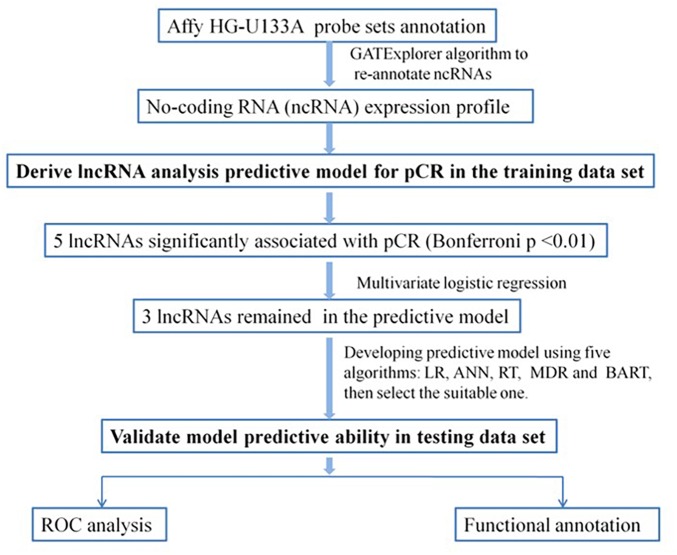
Diagram of the study. Develop predictive model for pCR and validate the efficiency of the lncRNA signature to predict pCR. LR, logistic regression; ANN, artificial neural network; RT, regression tree; MDR, multivariate adaptive regression splines; BART, Bayesian additive regression trees; pCR, pathological complete response; ROC, receiver operating characteristic.